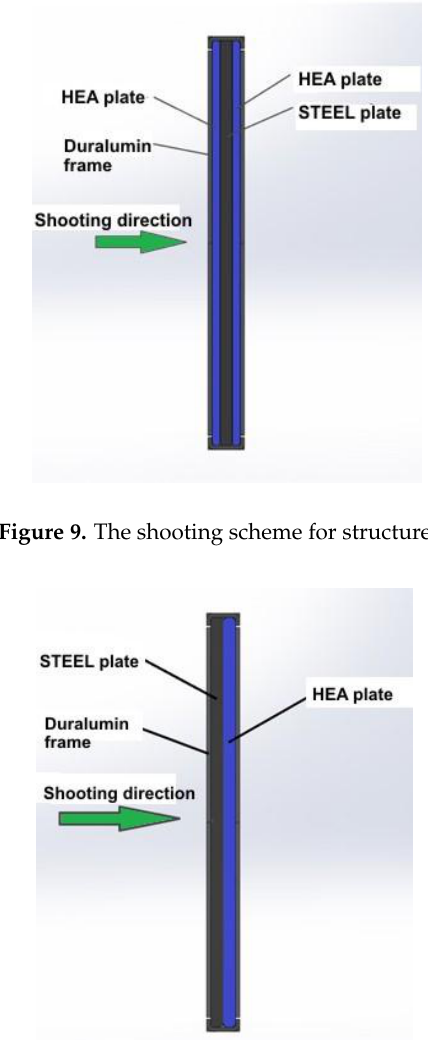
Figure 8. The shooting scheme for structure 1.